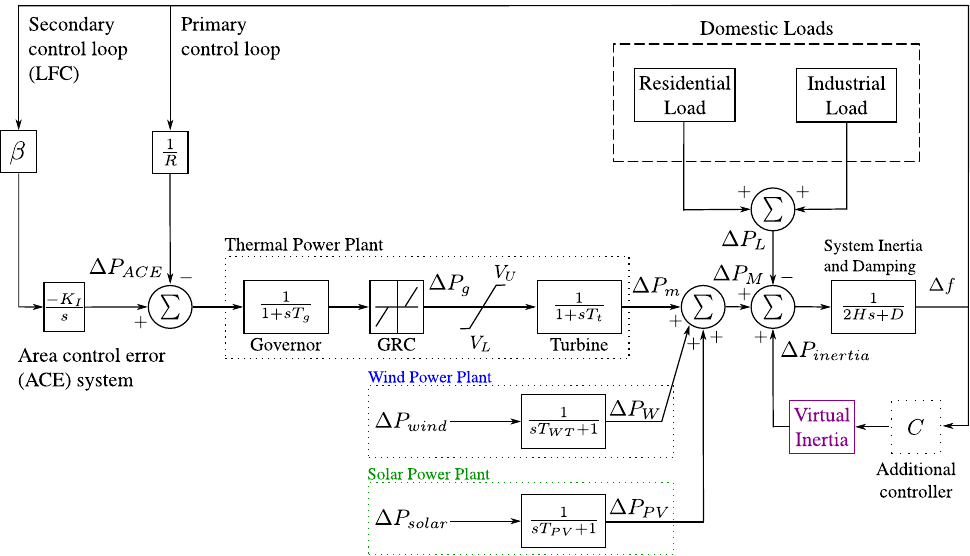
Figure 2. Schematic representation of an islanded microgrid with hierarchical control. GRC— generator rate constant; LFC—load-frequency control.